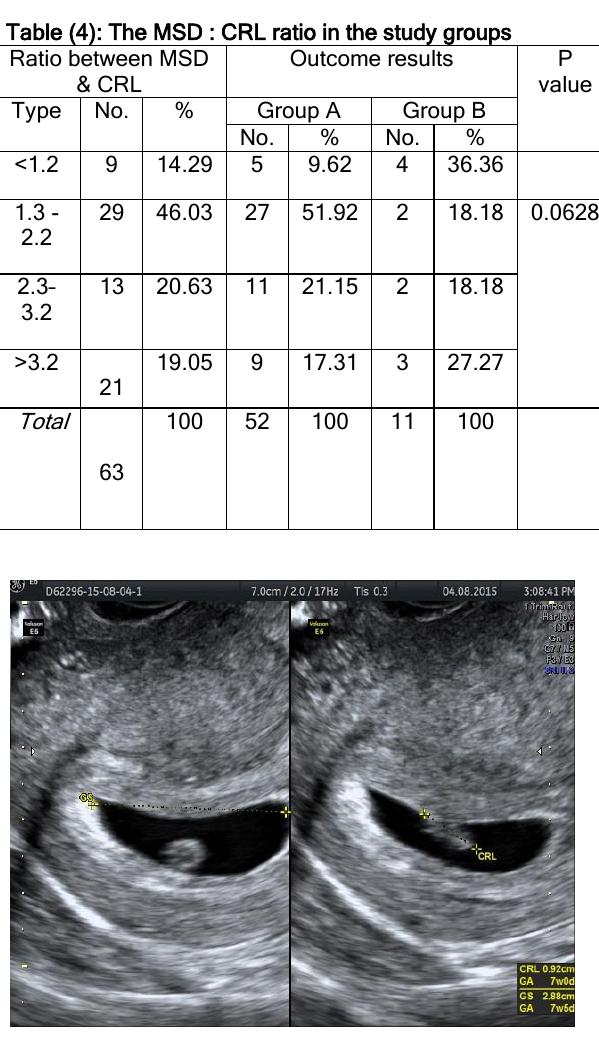
Figure (1): Ratio between MSD & CRL Regularity of the gestational sac